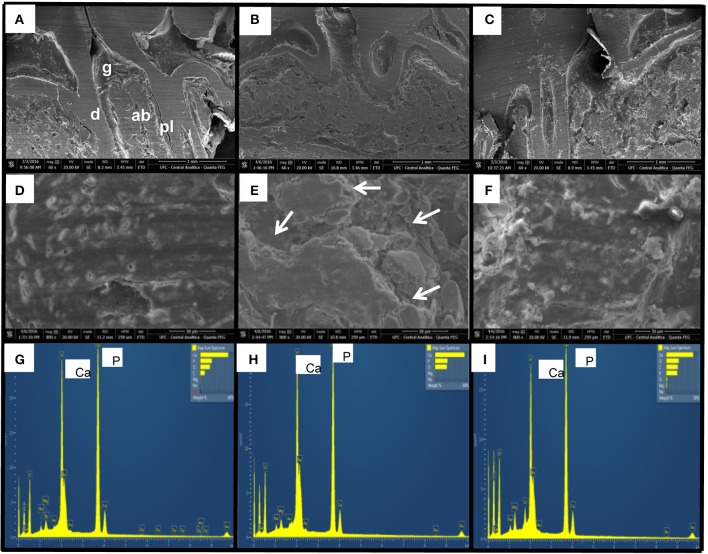
Effect of CLO on topography and mineral distribution of alveolar bone of rats with EP. Naïve (A,D,G), SAL (B,E,H), CLO (C,F,I). Dentin (d); Alveolar bone (ab); Periodontal ligament (pl); Gingiva (g). Arrows indicate irregularity on bone tissue. (Magnification 60x A–C; Magnification 800x D–F).